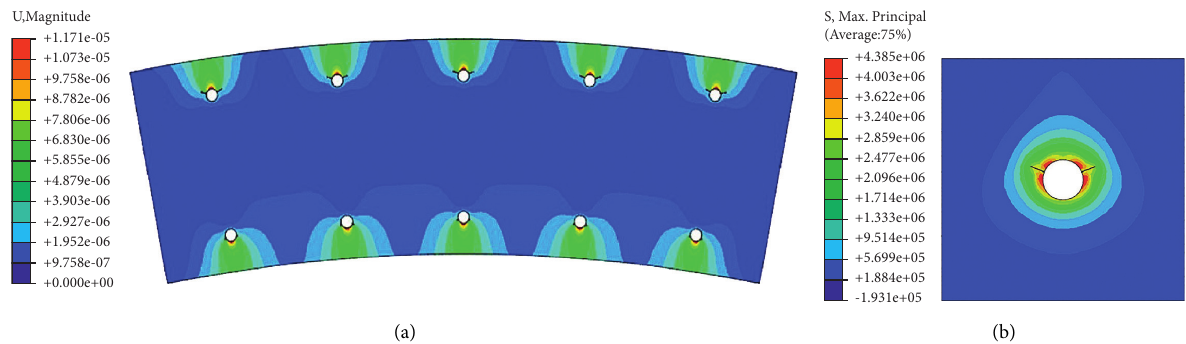
Figure 12: Degradation characteristics of the segment after 120 days of steel bar corrosion: (a) the displacement cloud during cracking and (b) the maximum principal stress cloud during